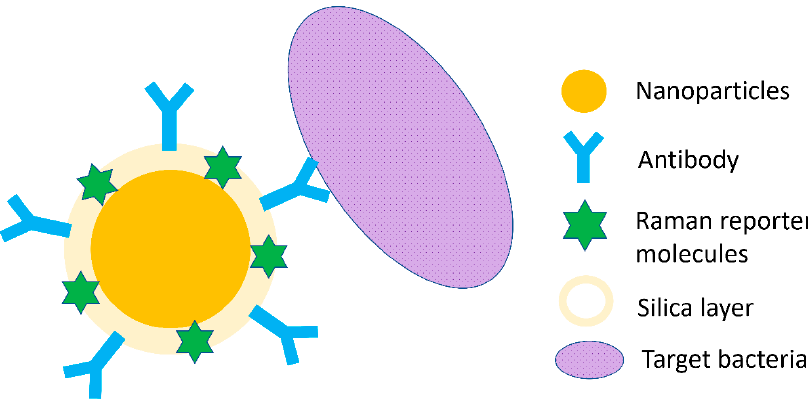
Figure 3. Schematic illustration of SERS tags.